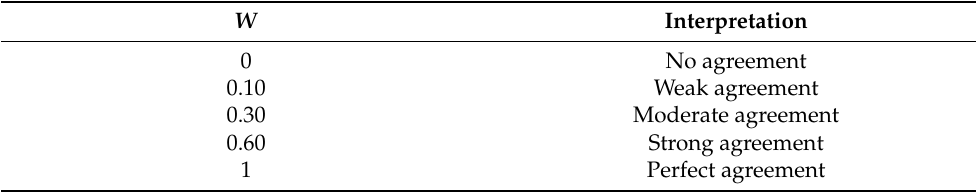
Table 2. Kendall’s W agreement degree scale.